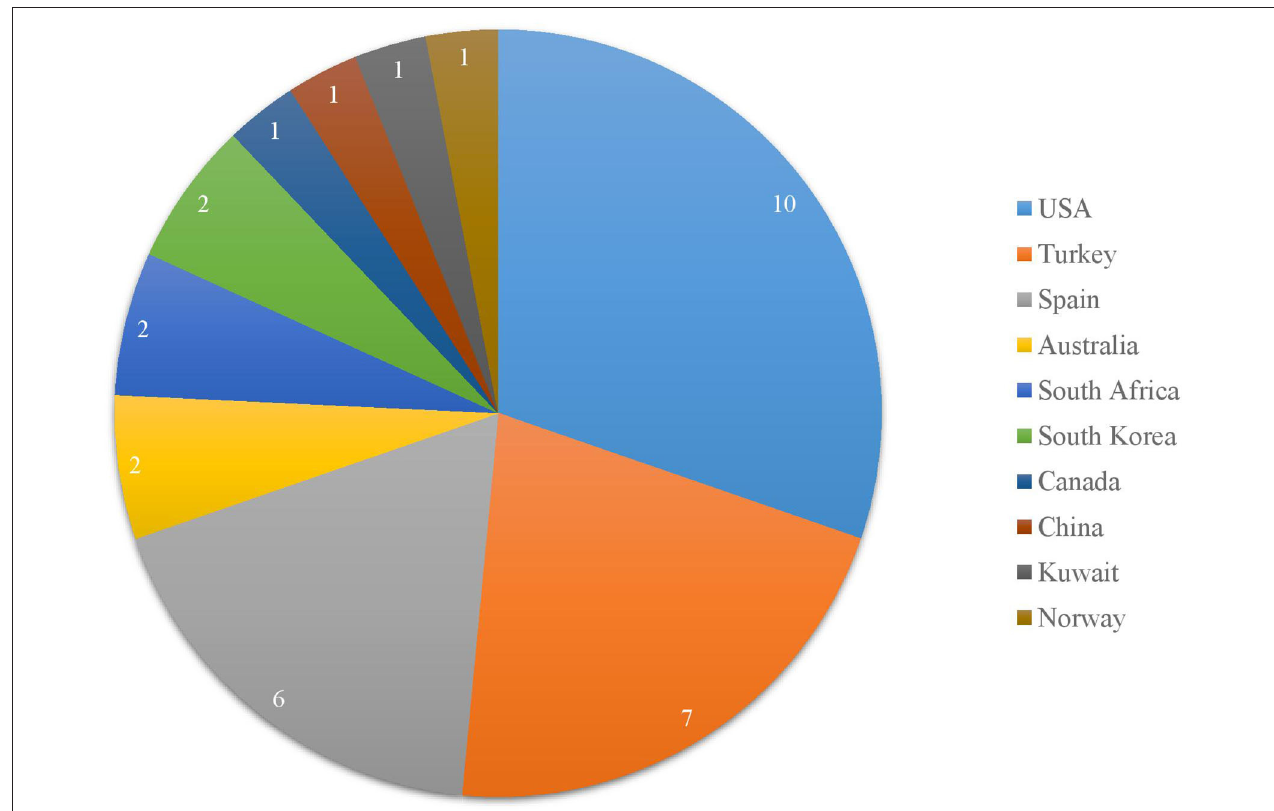
FIGURE 3 | Distribution of articles conducted in various